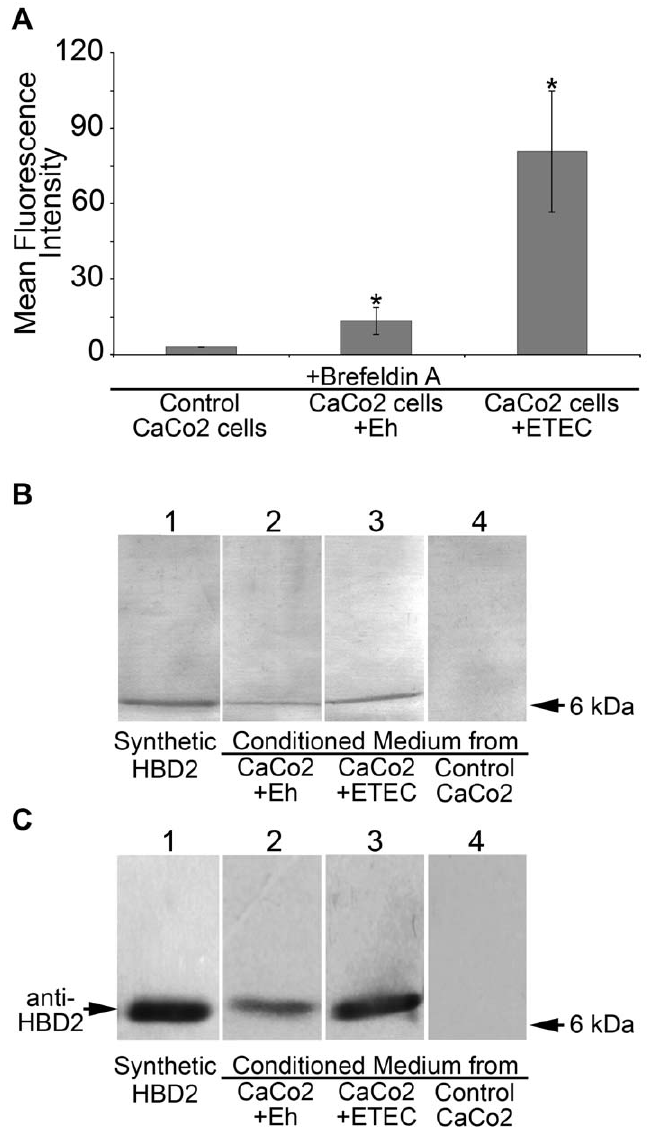
Figure 2. Production and release of HBD2 by CaCo2 cells exposed to Entamoebahistolytica trophozoites. A. Quantification of HBD2- positive CaCo2 cells after exposure to pathogens. CaCo2 cells were exposed for 2 h to ETEC or PFA-fixed trophozoites in the presence of 1.0 m g/ml Brefeldin A. Cells were permeabilized and fixed and then labeled with a specific anti-HBD2 antibody tagged with FITC. Levels of HBD2 inside the CaCo2 cells were determined by flow cytometry and data are presented as mean fluorescence intensity (MFI). Asterisks indicate statistical differences relative to control CaCo2 cells in three experiments done in triplicate ( P value , 0.01). B. Detection of HBD2 in cultured media from CaCo2 cells. Culture media were analyzed by SDS-PAGE in 15% gels. A silver-stained representative gel is shown. Lane 1, synthetic HBD2 peptide. Lane 2, CM from CaCo2 cells exposed to PFA-fixed E. histolytica trophozoites (CaCo2 + Eh). Lane 3, CM of ETEC-exposed CaCo2 cells (CaCo2 + ETEC). Lane 4, CM from CaCo2 cells not exposed to pathogens (Control CaCo2). C. Immunodetection of HBD2 in a parallel gel to the one shown in panel B. After electrophoresis, proteins were blotted onto nitrocellulose membranes and challenged with anti-HBD2 antibody. Lane 1, synthetic HDB2 peptide. Lane 2, CM of CaCo2 cells exposed to PFA-fixed Entamoeba histolytica trophozoites (CaCo2 + Eh). Lane 3, CM of CaCo2 cells exposed to ETEC (CaCo2 + ETEC). Lane 4. CM of CaCo2 cell cultures not exposed to pathogens (Control CaCo2).